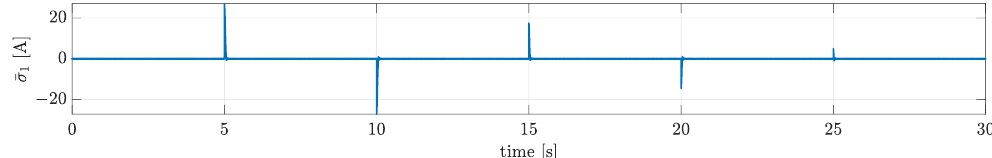
Figure 6. Boost mode. From top to bottom: active duty cycle d 2 ; generator side voltage v C . side voltage v C 2